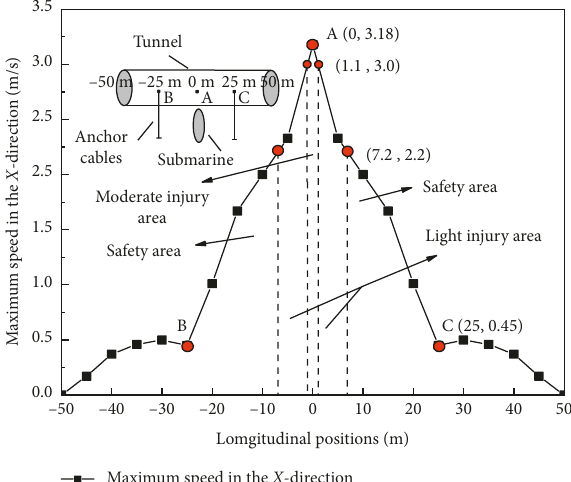
Figure 11: Time-history curve of X -direction speed at point